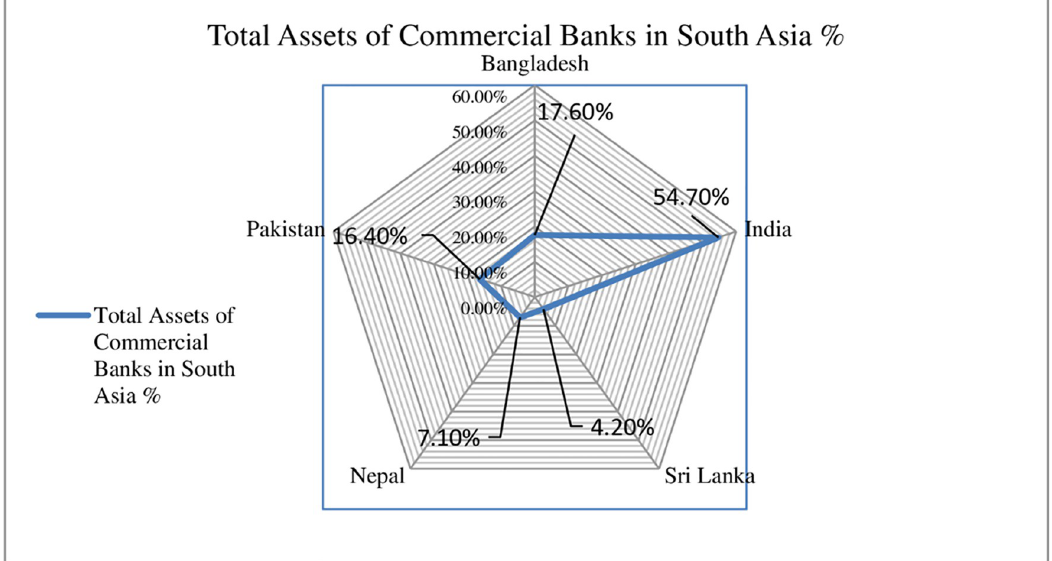
Fig 1. Percentage of total assets of South Asian commercial banks (Bank